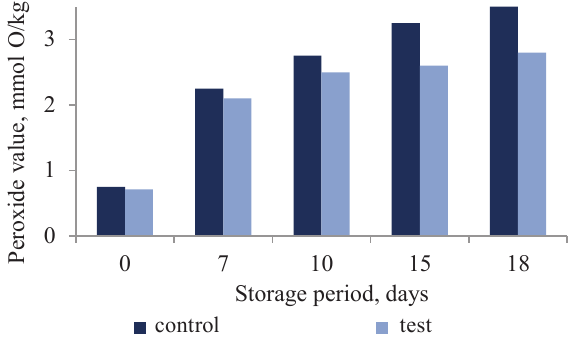
Figure 4 Effect of dry lingonberry marc extract on the peroxide value of paste without acidity regulators during storage